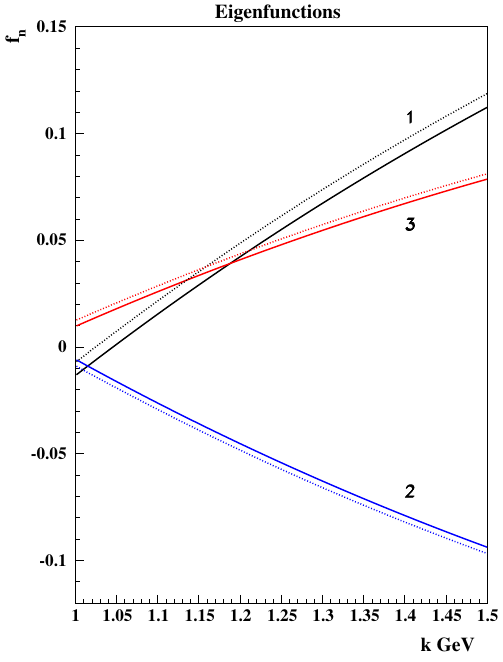
Fig. 13 Eigenfunctions 1, 2, 3, in the k region close to k 0 . The eigen- functions are plotted with the η n phases given by the AB fit. The first eigenfunction is plotted with the phase which gives zero overlap with the proton impact factor. The fits were performed with the b -value of the proton impact factor given by 10 GeV 2 (full lines) and 20 GeV 2 (dotted